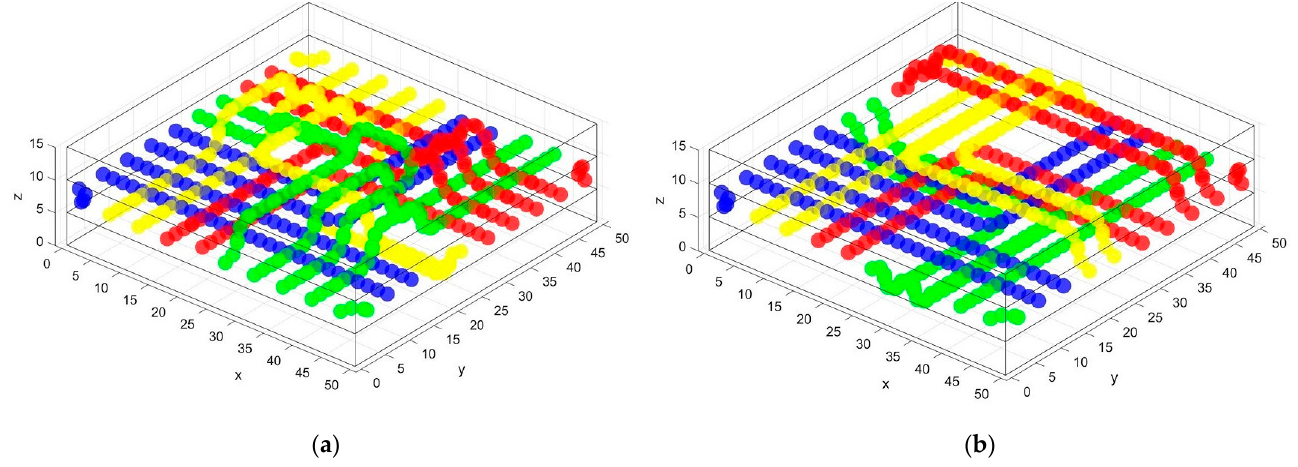
Figure 16. Trajectories of the UAVs scheduled at t i + 1 in ( a ) mode 1 and ( b ) mode 2. One UAV is represented by one color and UAVs coming from the same way have the same color.